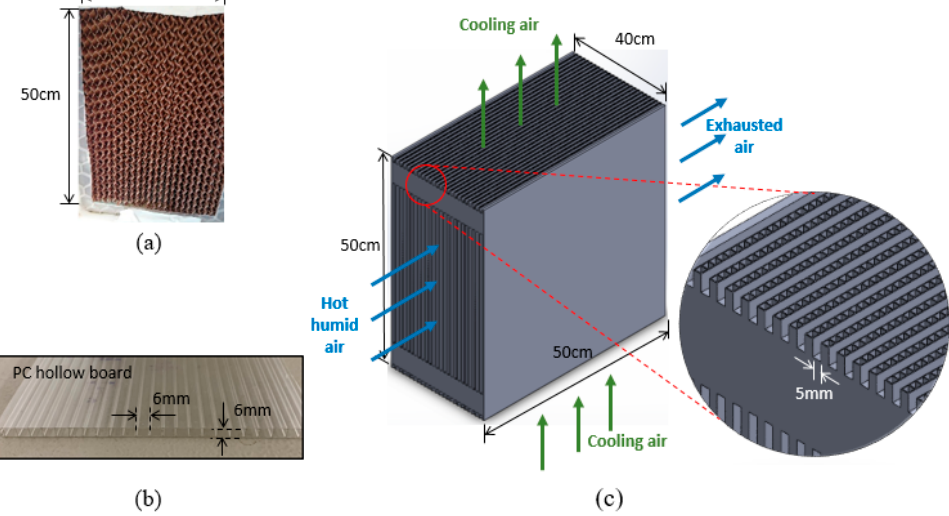
Figure 2. ( a ) Photo of the cellulose pad in humidifier; ( b ) Photo of a piece of hollow polycarbonate (PC) board with the internal spacing of 6 mm by 6 mm; ( c ) 3D schematic structure of a stack of PC boards assembled with a spacing of 5 mm by fixture and epoxy.